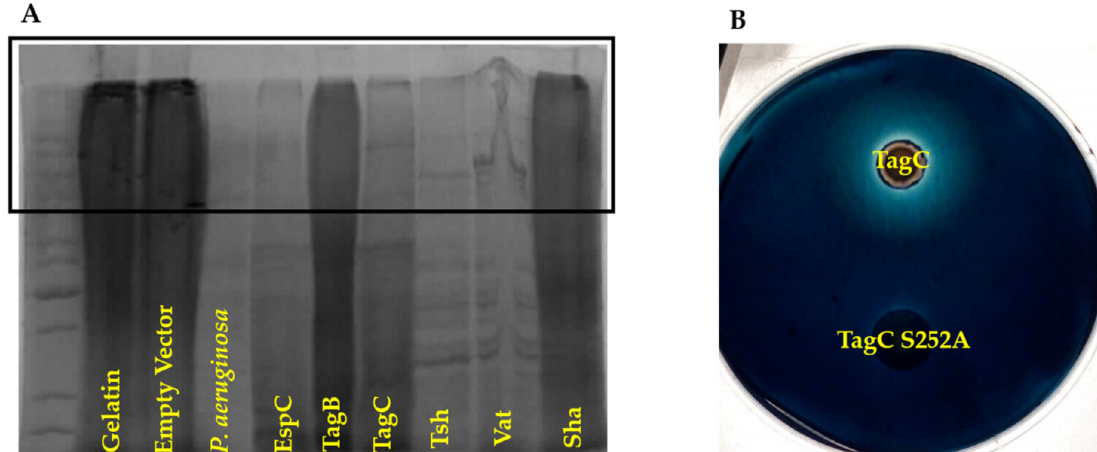
Figure 8. TagC demonstrates serine-protease dependent gelatinase activity, but not TagB nor Sha. ( A ) Zones of 1% bovine skin gelatin hydrolysis are visible in the stacking region of the SDS-PAGE gel (boxed area), concentrated supernatant extracts of SPATEs (5 µ g of protein per well) were incubated at 37 ◦ C for 48 h prior to migration. ( B ) Gelatinase activity of TagC was tested in a medium containing 1.5% agarose and 1% bovine skin gelatin. The disc inoculated with a clone expressing TagC or its serine catalytic site mutant variant, TagC S252A, were inoculated on the agar surface and were incubated for 48 h at 37 ◦ C. Zones of gelatin lysis were visualized by staining with 0.1% amido-black in 3.5 M acetic acid for 15 min, followed by destaining with 5% acetic acid and 0.5% glycerol for 6